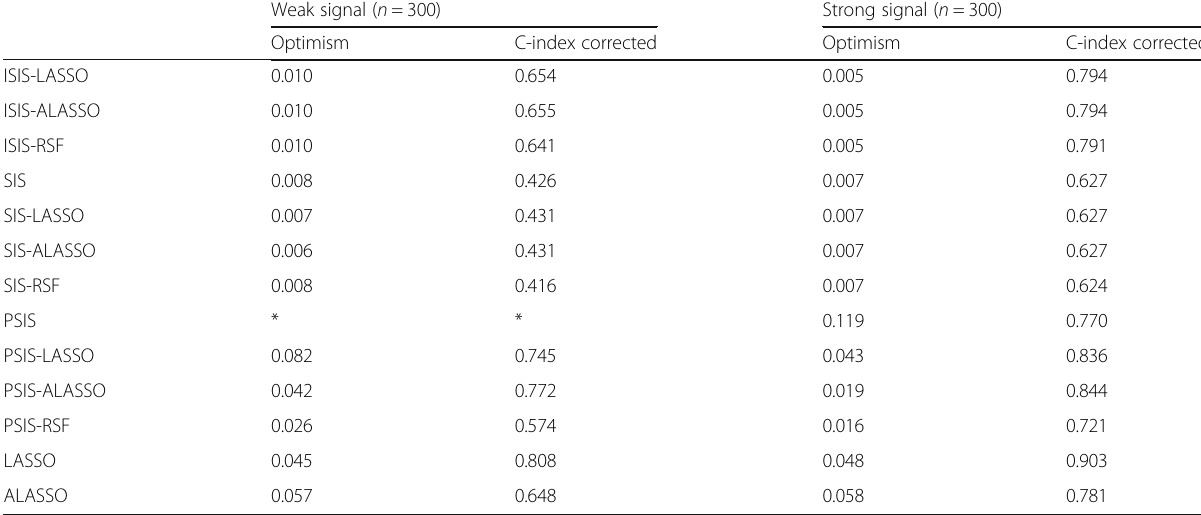
Table 4 Mean optimism and corrected c-index over 100 boostrapped samples